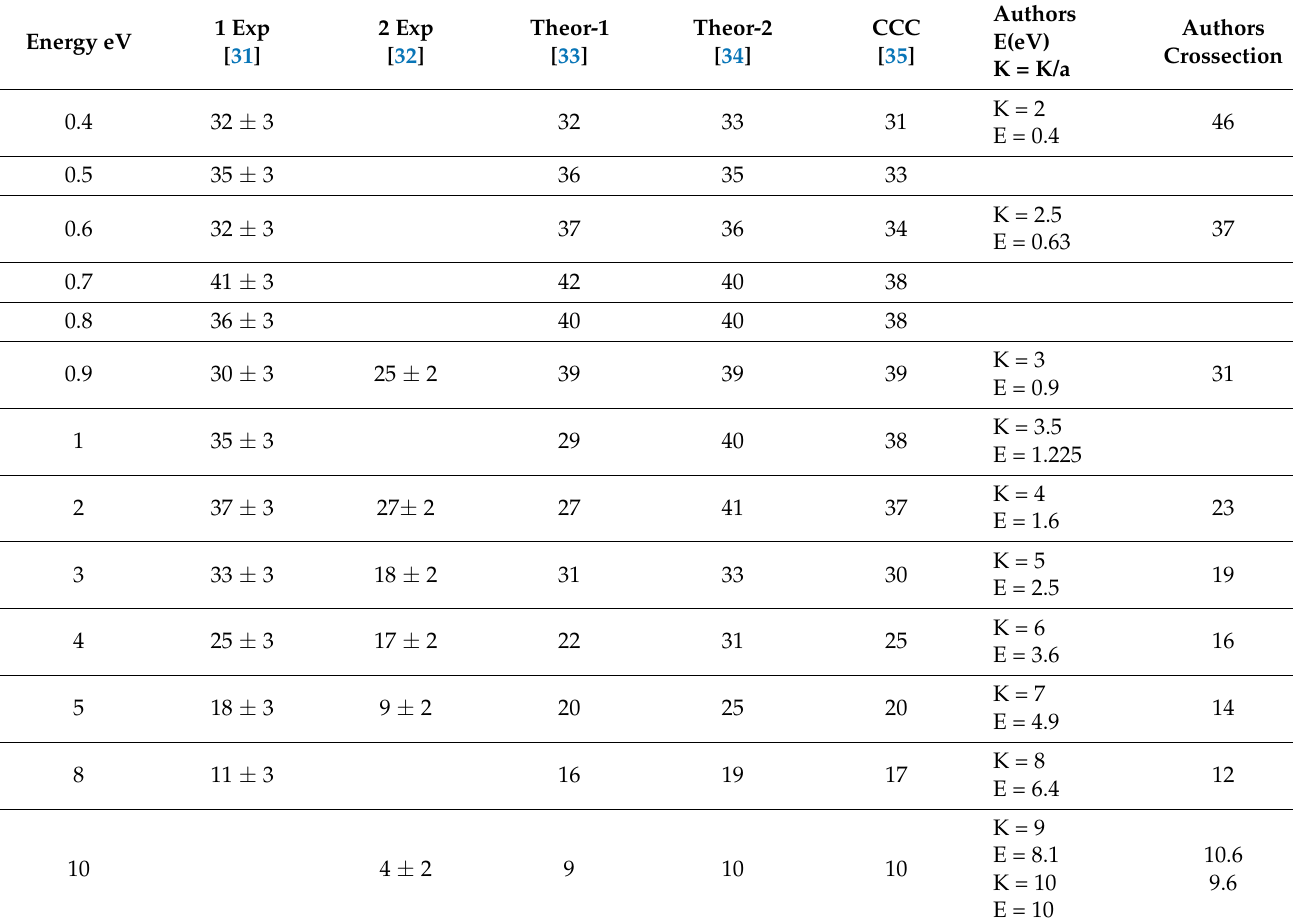
Table 1. Total positronium-formation cross-section (10 − 16 cm 2